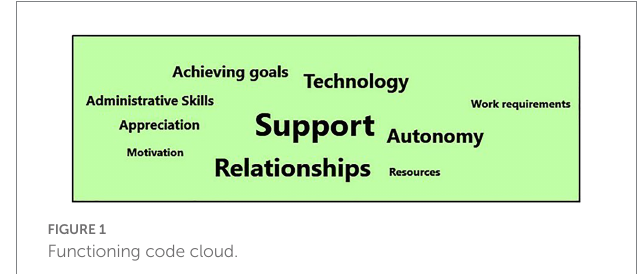
FIGURE 1 Functioning code